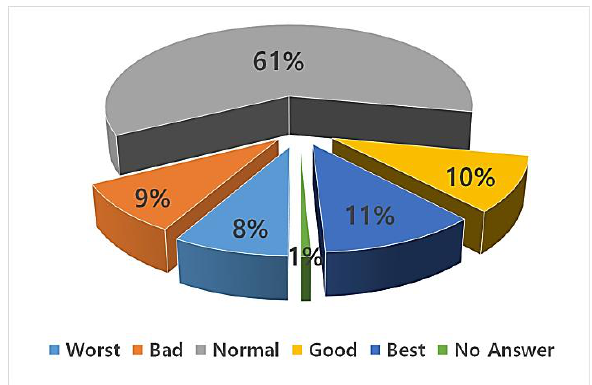
Figure A11. User preference for GPS plotter display size.